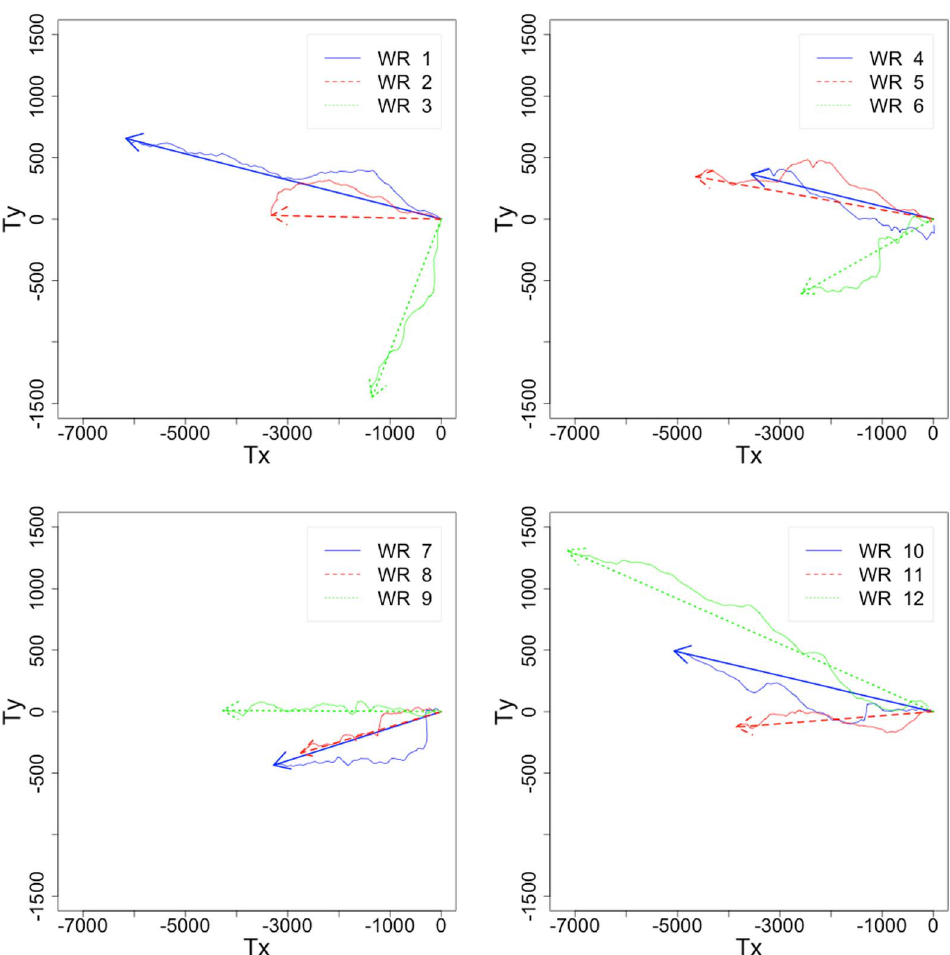
Figure 4. Hodographs of the 12 wind regimes. These graphs are performed with the wind stress components Tx and Ty. Arrows give the mean pattern for the 30 days. The numbers correspond to the wind regime indices (see Table 4).